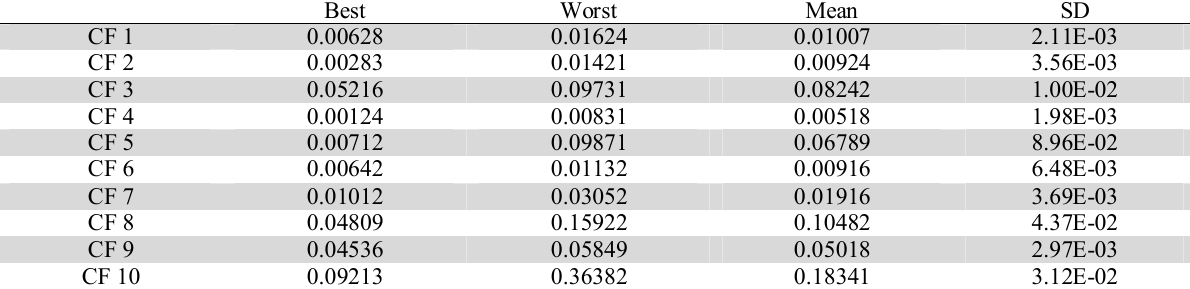
IGD value obtained with MO-ITLBO for different constrained test functions (CF1-CF10) in 30 independent runs.